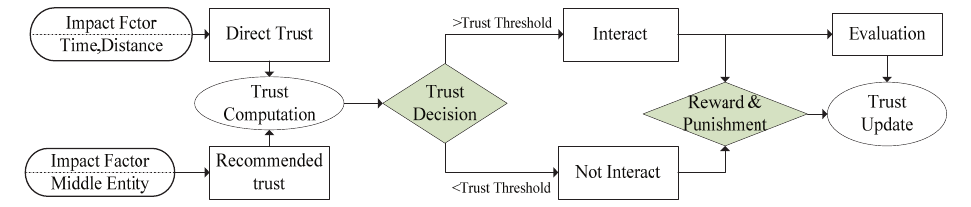
Fig. 1. General process of behavior trust